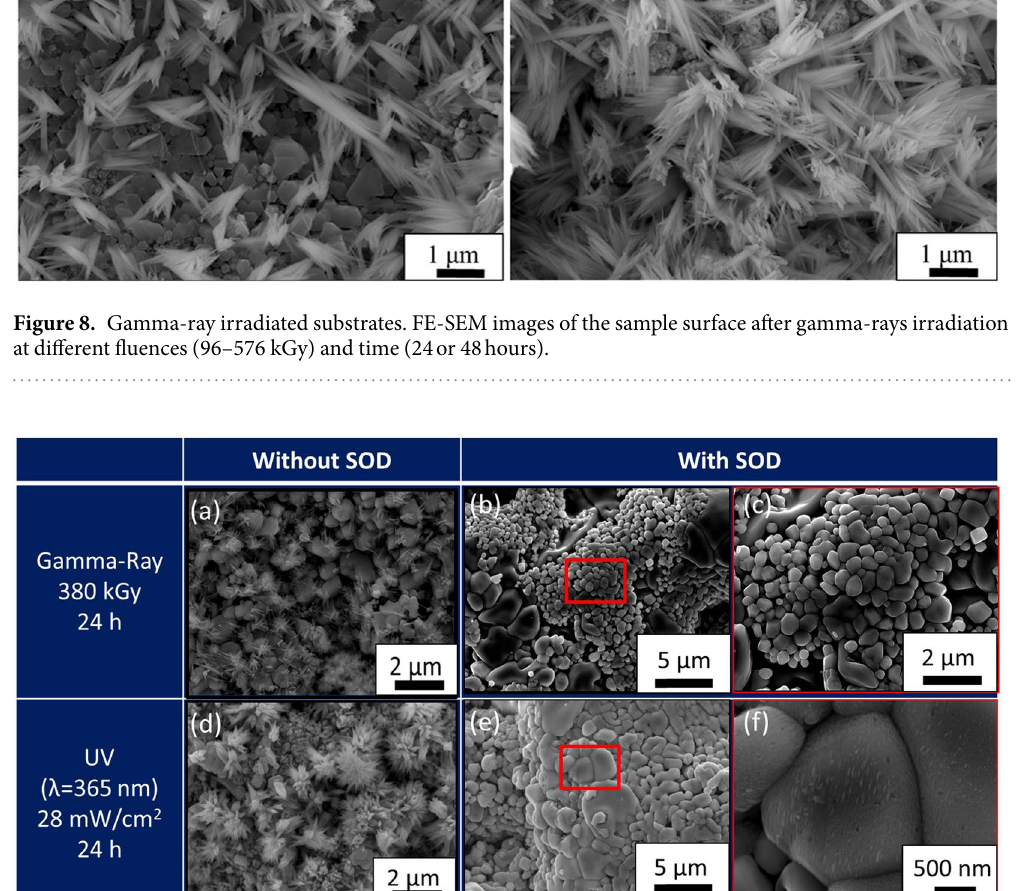
samples of CuO-annealed (see Supplementary Fig. S4), CuO-plasma and flowered CuO formed by SPSC (Fig. 10). The average inhibition zones for Staphylococcus were 1.0 cm for CuO-annealed, 1.2 cm for CuO-plasma and SPSC-CuO, and 0 cm for raw-Cu. The Escherichia coli K12 average inhibition zones were 1.0 cm for CuO-annealed, 1.1 cm for CuO-plasma and SPSC-CuO, and 0 cm for raw-Cu. From these results, we observed that the anti- microbial activities of plasma-treated CuO and flower-shaped SPSC-CuO were higher than CuO-annealed. Furthermore, the plasma-treated CuO and SPSC-CuO had higher antibacterial activity against S. aureus than